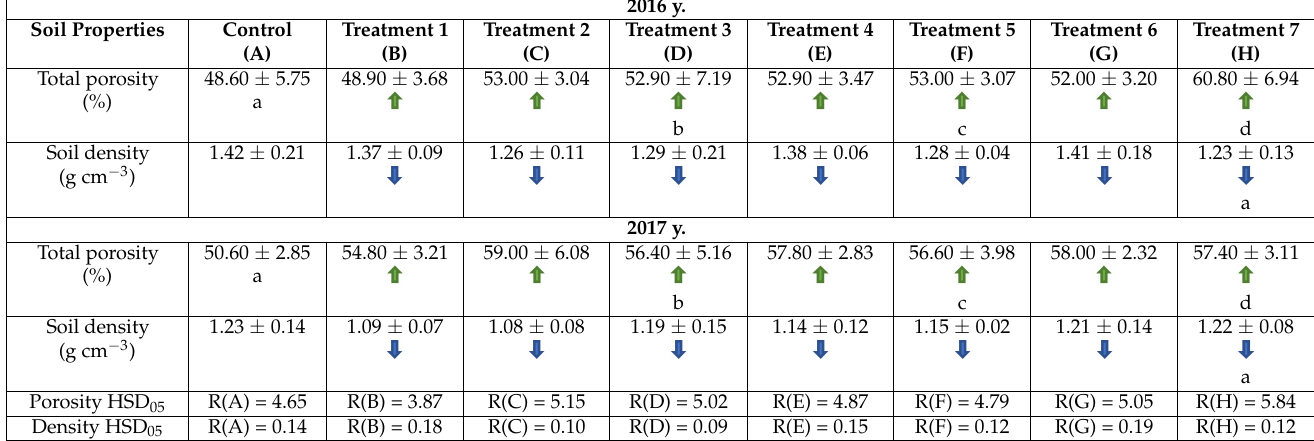
Table 2. Total soil porosity and soil density before the